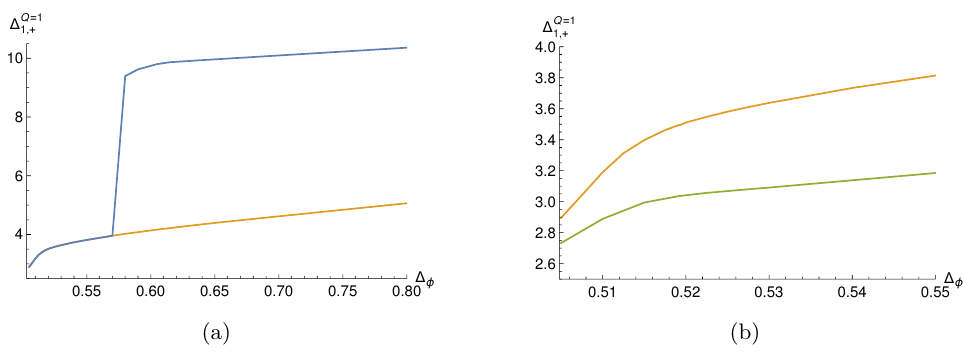
Figure 8 . On the left: bound on the dimension of the first charge-1 parity-even spin-1 operator as a function of ∆ φ . Assuming a gap of 4 in the charge-1 parity-even spin-2 sector removes the fake primary effect. On the right: same bound with and without the assumption of no relevant neutral vectors besides J . The bounds have been obtained at Λ = 13